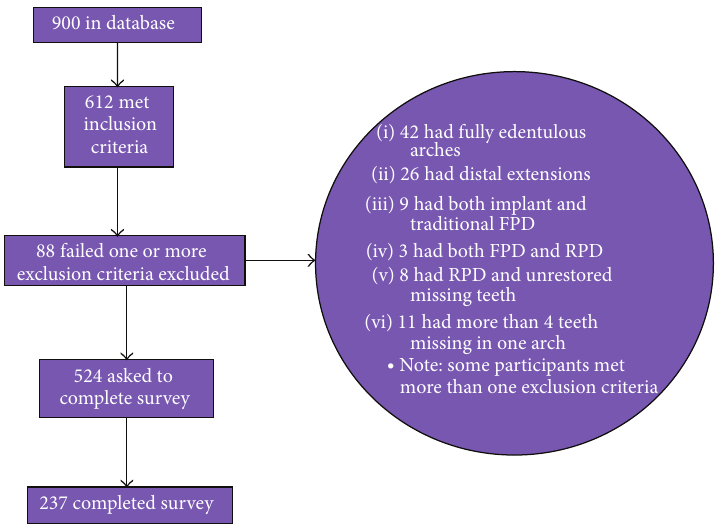
Figure 2: Study inclusion